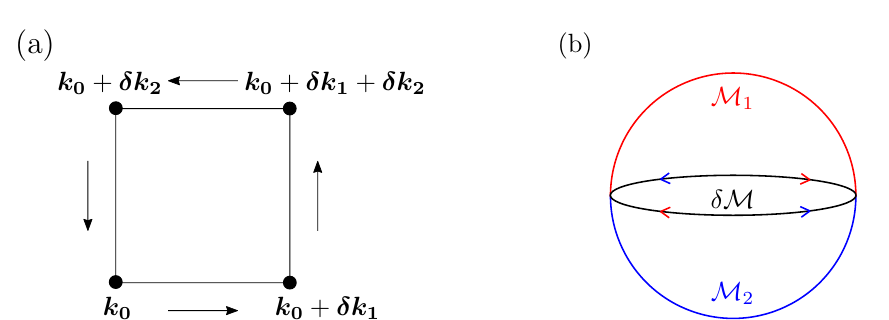
Figure 10: (a) Path considered in the statement of Ambrose-Singer theorem in Eq. (124). (b) Sphere tion of the (first) Chern